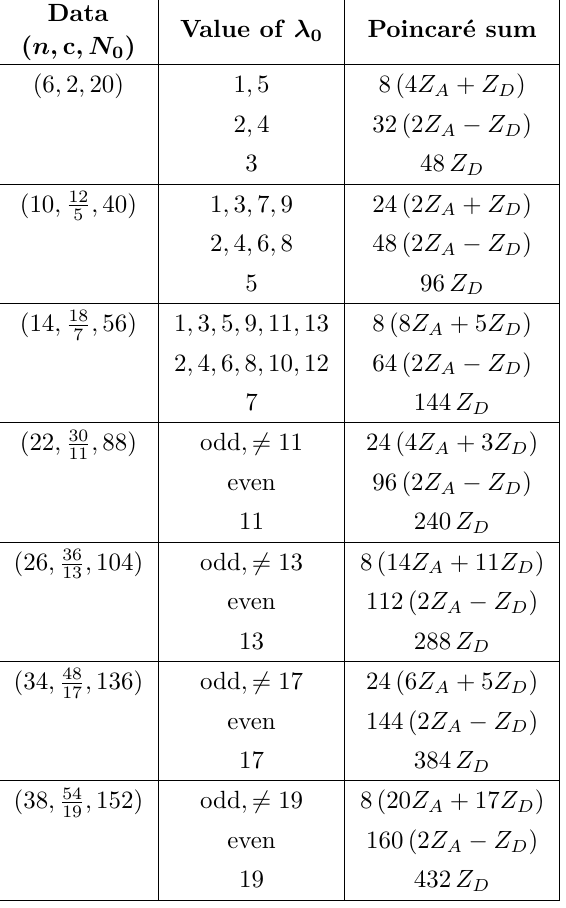
Table 2. Poincaré Sums for SU(2) k WZW model with two modular